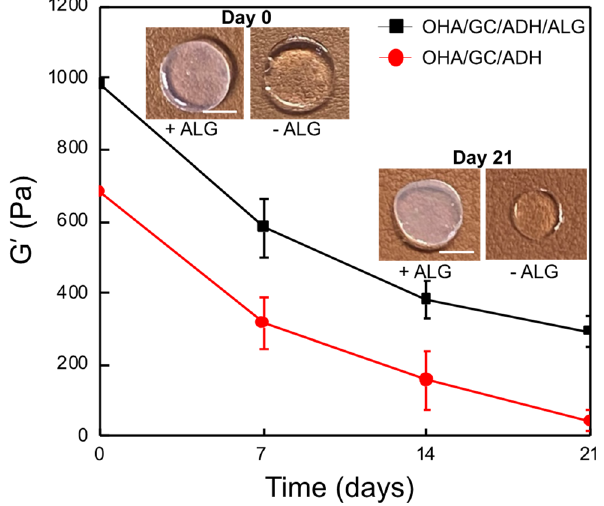
Figure 3. Changes in storage shear moduli of OHA/GC/ADH/ALG hydrogels (black squares) and OHA/GC/ADH hydrogels (red circles) ([OHA] = 2 wt%, [GC] = 1 wt%, [ADH] = 0.3 wt%, [ALG] = 0.3 wt%, [Ca 2+ ] = 60 mM). All gel disks (10 mm diameter, 1 mm thick) were prepared, treated with calcium ions for second cross-linking ([Ca 2+ ] = 60 mM,1 min), and incubated in DPBS at 37 °C for 3 weeks (scale bar, 0.5 mm).